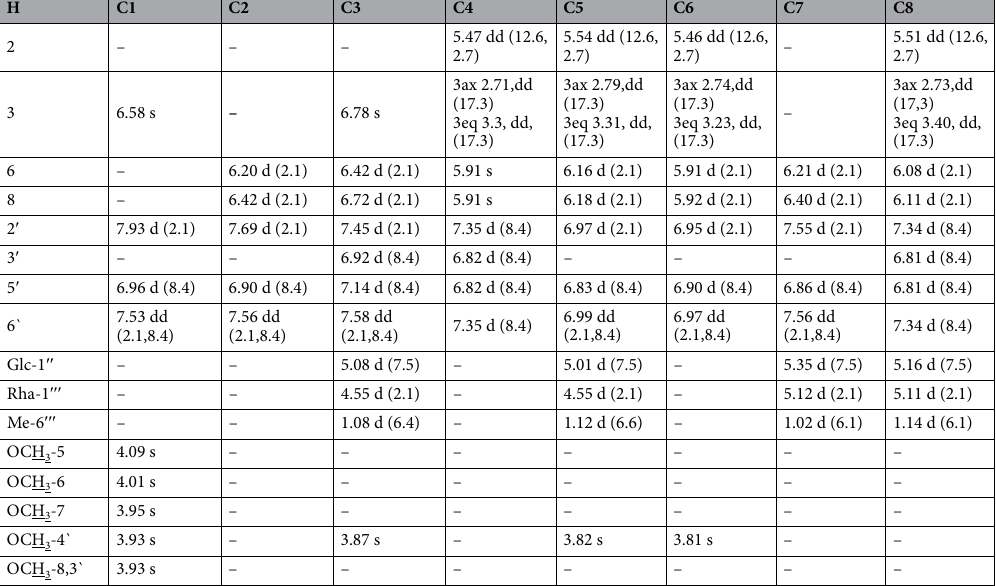
Table 1. 1 H NMR chemical shifts (δ ppm) for compounds C1–C8 (DMSO-d 6 , 400 MHz). Coupling constants are (J in Hz) in